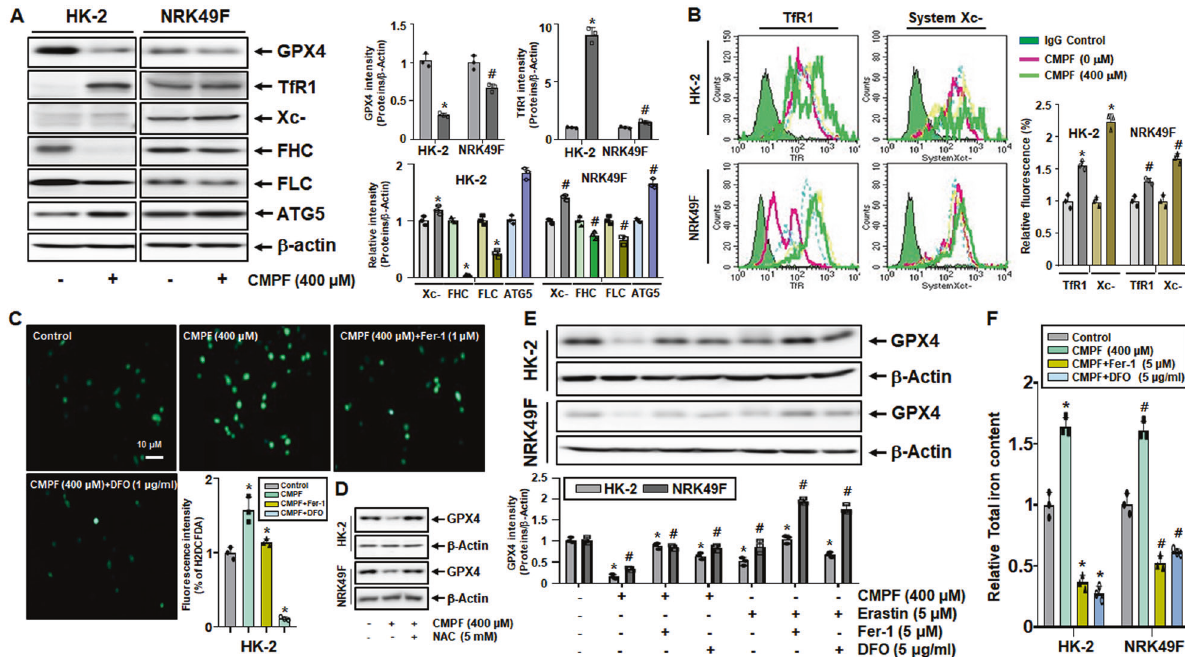
Fig. 7 Regulation of ferroptosis-related proteins and GPX4 expression by CMPF, Erastin, Fer-1, and DFO treatment in HK-2 and NRK49F cells. HK-2 and NRK49F cells were harvested after treatment with 400 μ M of CMPF or 5 μ M of erastin for 24 h under serum starvation. The cells were pretreated with ferroptosis inhibitor ferrostatin-1 (Fer-1, 1 or 5 μ M) and iron chelate deferoxamine (DFO, 1 or 5 μ g/ml) for 1 h before the CMPF treatment. ( A ) Expression of GPX4, TfR1, System Xc-, FHC, FLC, and ATG5 proteins in cells treated with 400 μ M CMPF as detected by immunoblotting. The relative protein levels are shown. ( B ) Expression of TfR1, System Xc- protein in cells treated with 0, 100, 200, or 400 μ M CMPF as detected by fl ow cytometry. The graph on right shows the relative fl uorescence values of TfR1 and System Xc- (control is set to 1). ( C ) HK2 cells were pretreated with 1 μ M Fer-1 or 1 μ g/ml DFO for 1 h, then treated with 400 μ M CMPF, and incubated with CM-H2DCFH-DA to measure ROS levels. The bar graph shows the fl uorescence intensity (control is set to 1). ( D ) After pretreatment of cells with 5 mM N-Acetylcysteine (NAC) for 1 h, the expression of GPX4 protein in cells treated with 400 μ M CMPF was detected by immunoblotting. The bar graph represents the fl uorescence intensity with the control set to 1. ( E ) GPX4 protein levels in cells pretreated with 5 μ M of Fer-1 or 5 μ g/ml of DFO for 1 h, and then treated with 400 μ M of CMPF or 5 μ M of erastin, as measured by immunoblotting. The relative protein levels are shown. ( F ) Relative levels of total iron content in cells treated with 400 μ M CMPF, following the pretreatment with 5 μ M of Fer-1 or 5 μ g/ml of DFO